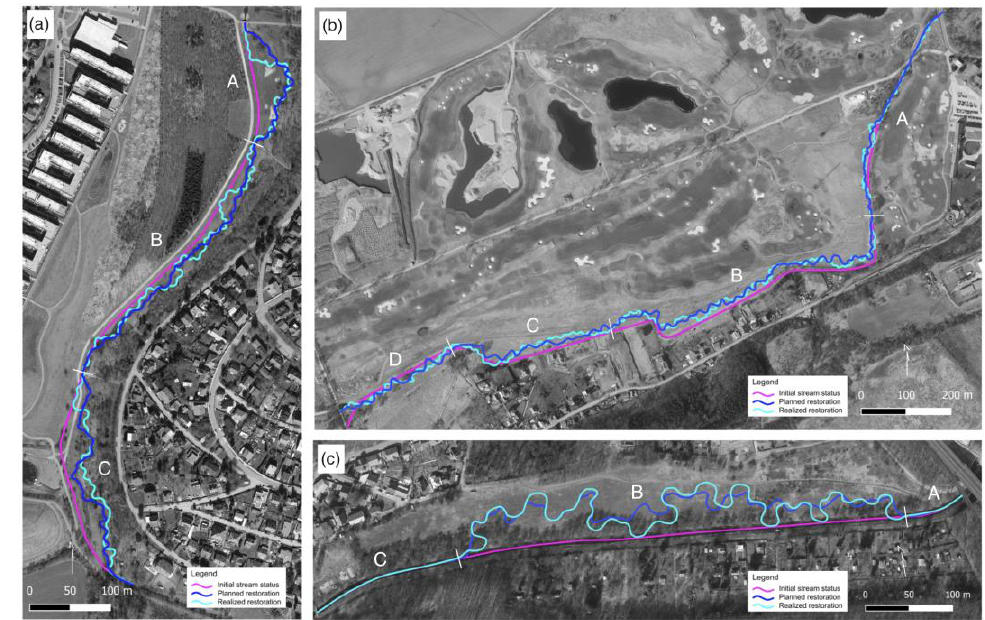
Figure 5. Stream restoration projects featuring the channel’s pre-restoration, planned, and post-restoration status with marked delineation of reaches, used for the assessment of geometric properties. ( a ) Hostavický brook, ( b ) Lipanský brook, and ( c ) Rokytka brook.